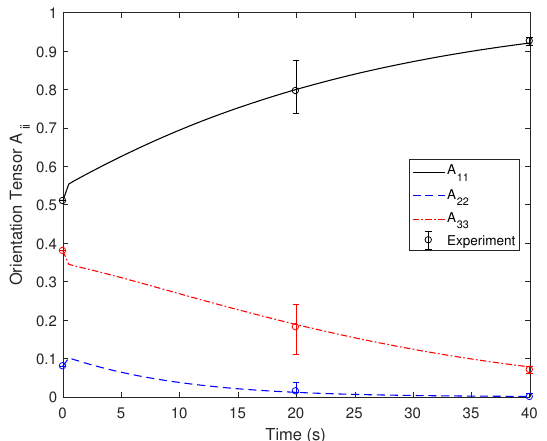
Figure 6. Fiber orientation evolution under constant planar extension at a strain rate of 0.05 s − 1 with experimental results from [18] in points and simulation results in continuous lines.